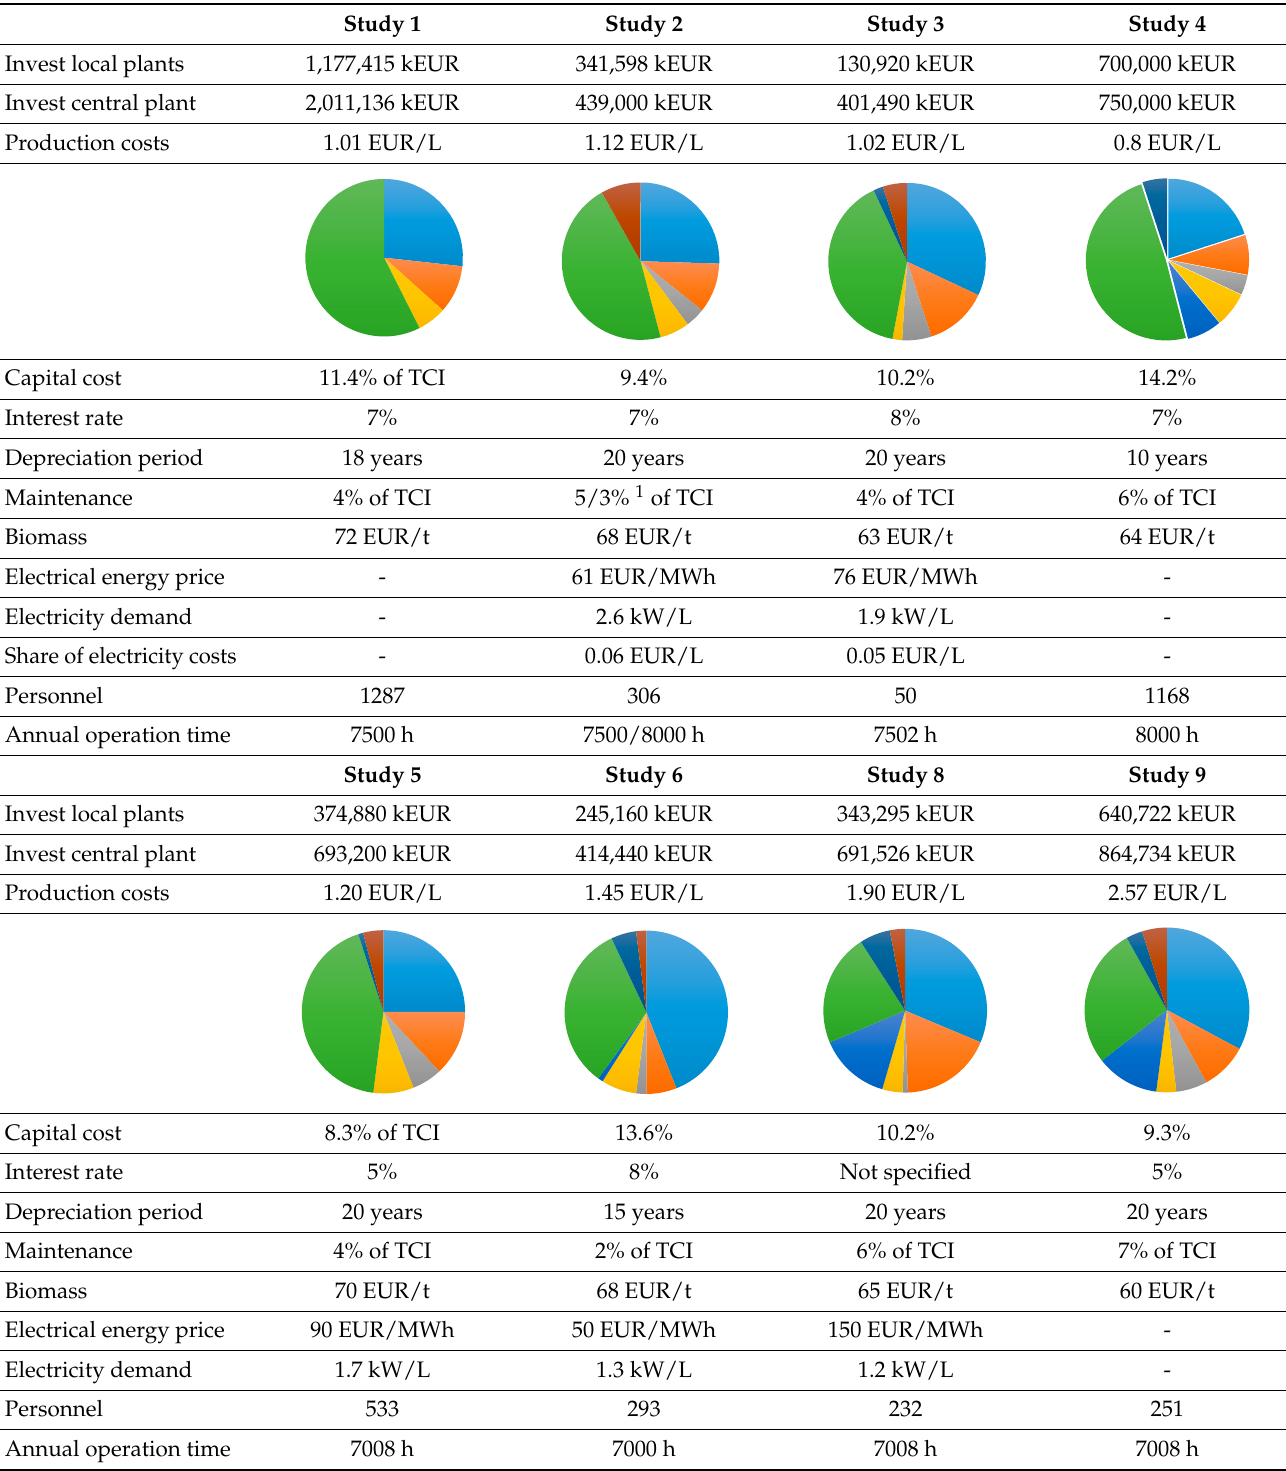
Figure 4. Specific production costs and their composition by fixed and variable costs. Table 5. Economic parameters and cost contributions of the BtL cost evaluation; Colors of the pie chart: light blue: capital cost; orange: maintenance; grey: tax & insurance; yellow: personnel; blue: overhead; green: biomass; dark blue: materials; brown: utilities.